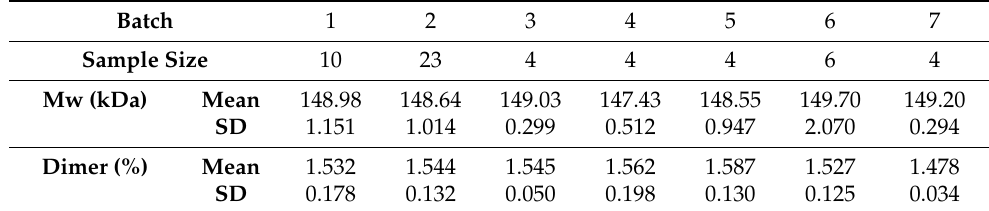
Figure 1. Data sets and QR estimated from variance components for k = 2 (inner lines) and k = 3 (outer lines). ( A ) correspond to molecular weight and ( B ) for dimer CQAs. Table 1. Summarized statistics of experimental data (sample size, mean, and standard deviation) for molecular weight (Mw) and dimer content as percent of total bevacizumab concentration (di- mer).